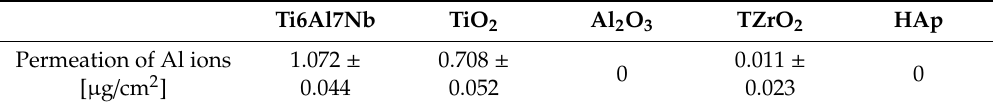
Table 4. Permeation of Al ions for all one-component coatings and uncovered Ti6Al7Nb substrate. Ti6Al7Nb TiO 2 Permeation of Al